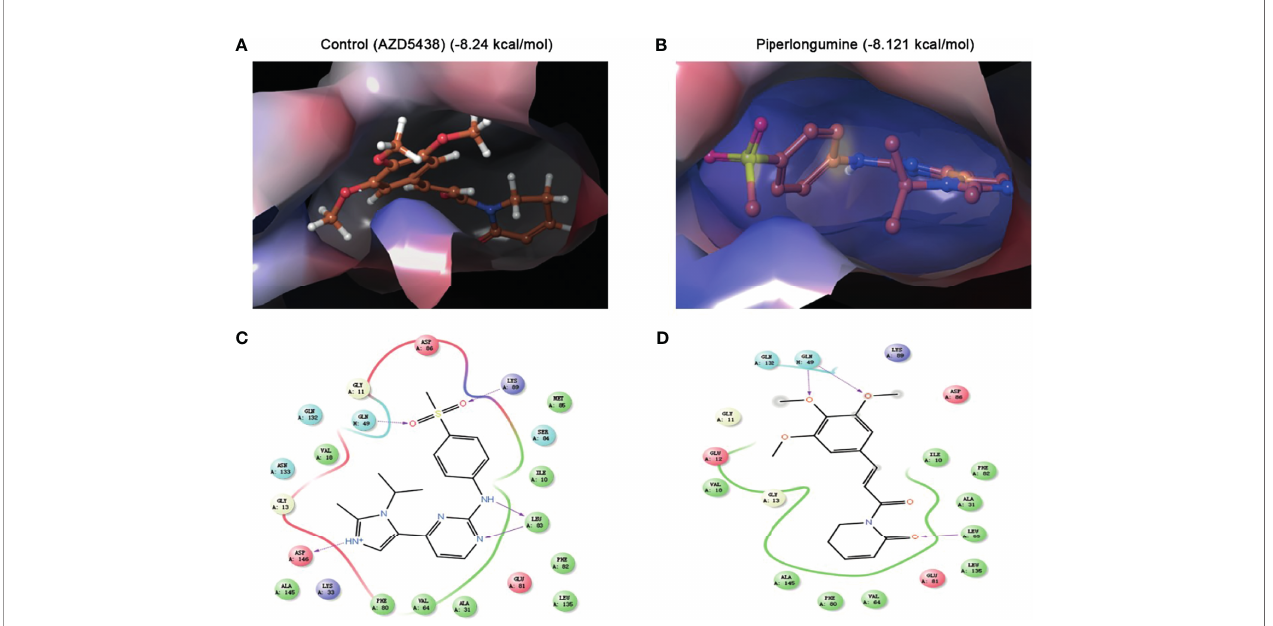
FIGURE 5 | Molecular docking simulation for piperlongumine and CDK1. (A, B) Docked structure and interactions of drugs [ (A) AZD5438 (control), (B) piperlongumine] binding to CDK1. (C, D) 2D interaction diagrams of the residues of CDK1 involved in the binding of drugs [ (C) AZD5438 (control), (D) piperlongumine]. The Schrodinger Glide docking protocol was used for this